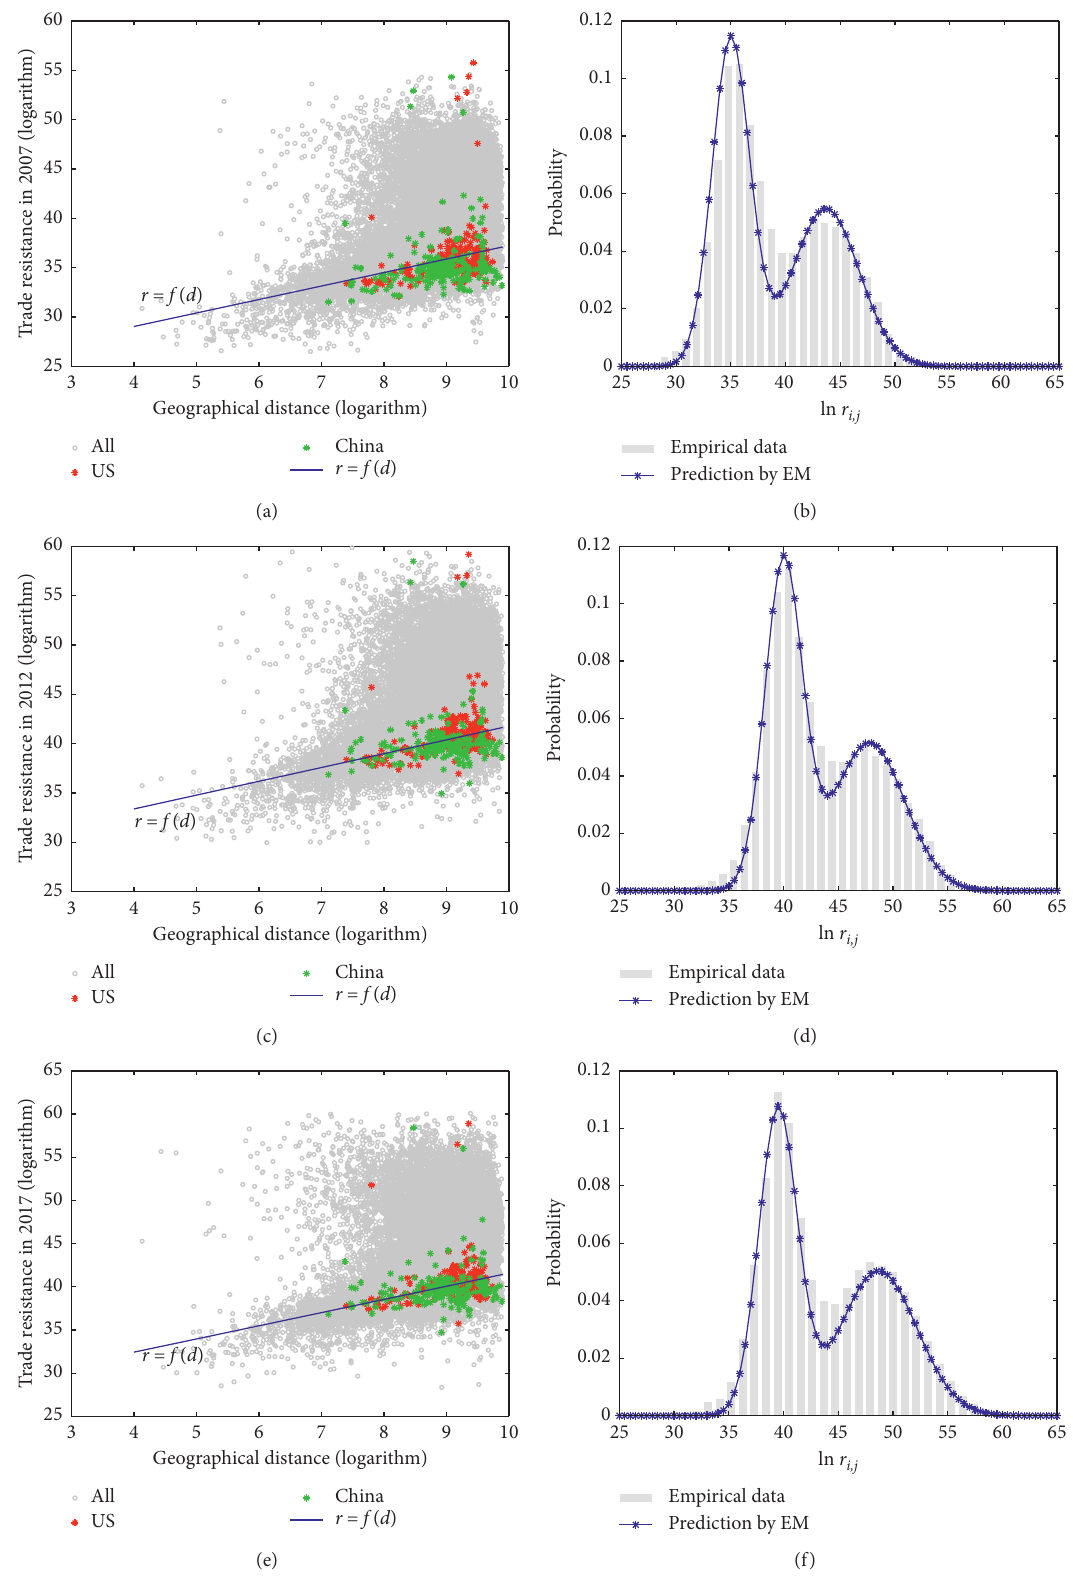
Figure 1: Fitting the distribution characteristics of trade resistance, based on the hypothesis of two categories. In (a), (c), and (e), gray dots show the trade resistance between countries around the world. In (b), (d), and (f), gray bars express the trade resistance quantified from the extended gravity model; the blue dotted line is the fitted results with the EM